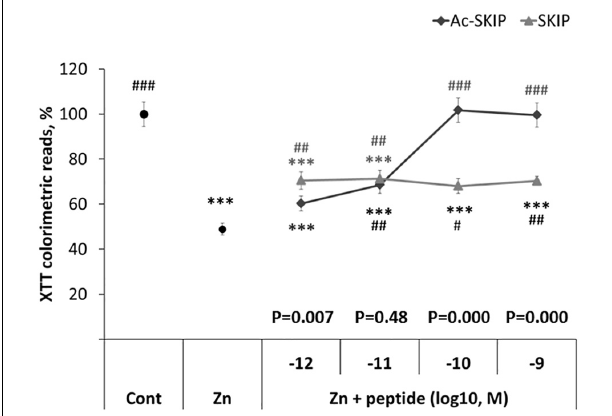
FIGURE 1 | SKIP and Ac-SKIP exhibit protective activity against zinc cytotoxicity in differentiated neuroblastoma N1E-115 cells. Results of mitochondrial activity were obtained by XTT colorimetric assay. “Cont” – cells without any treatment ( n = 60); “Zn” – cells, exposed to 400 µ M of zinc ( n = 58); “Zn + peptide” – cells treated with zinc (400 µ M) and different concentrations of Ac-SKIP or SKIP: 10 − 12 M Ac-SKIP ( n = 22)/SKIP ( n = 14), 10 − 11 M Ac-SKIP ( n = 22)/SKIP ( n = 14), 10 − 10 M Ac-SKIP ( n = 22)/SKIP ( n = 14), 10 − 9 M Ac-SKIP ( n = 22)/SKIP ( n = 14). Statistical analysis was performed by One-way ANOVA: ∗∗∗ p < 0.001, post hoc comparisons made in reference to “Cont” group; # p < 0.05, ## p < 0.01, ### p < 0.001, post hoc comparisons made in reference to “Zn” group. Statistical analysis within the concentration group of peptides was done by the Student’s t -test and P -values are displayed on the graph above concentration scale of